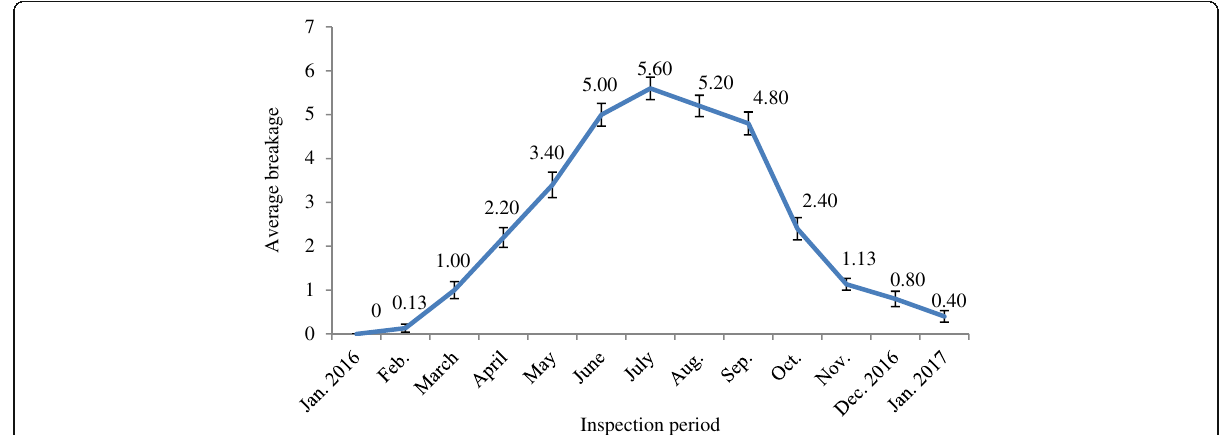
Fig. 4 Average monthly frond breakage/1 tree at Siwa date palm groves (from January 2016 to January